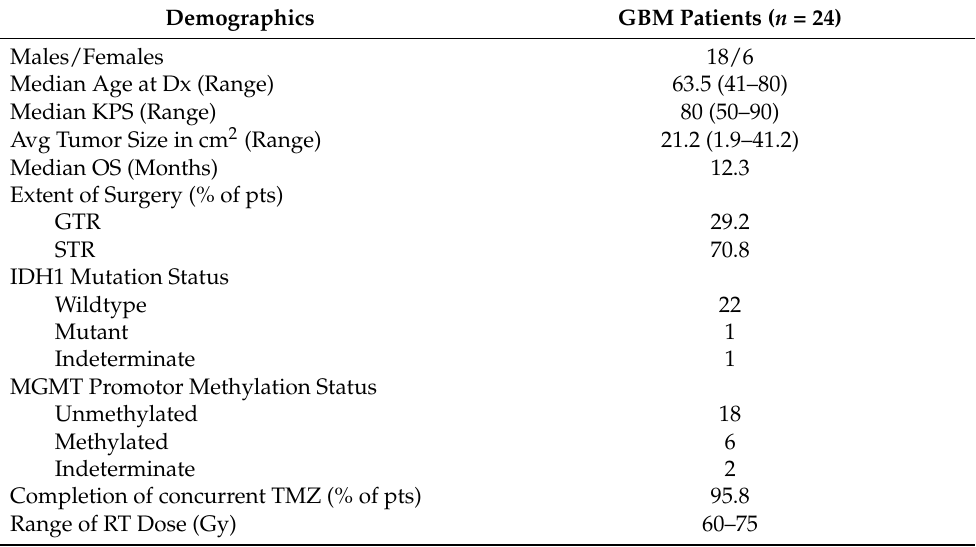
Table 1. Patient, tumor, and treatment